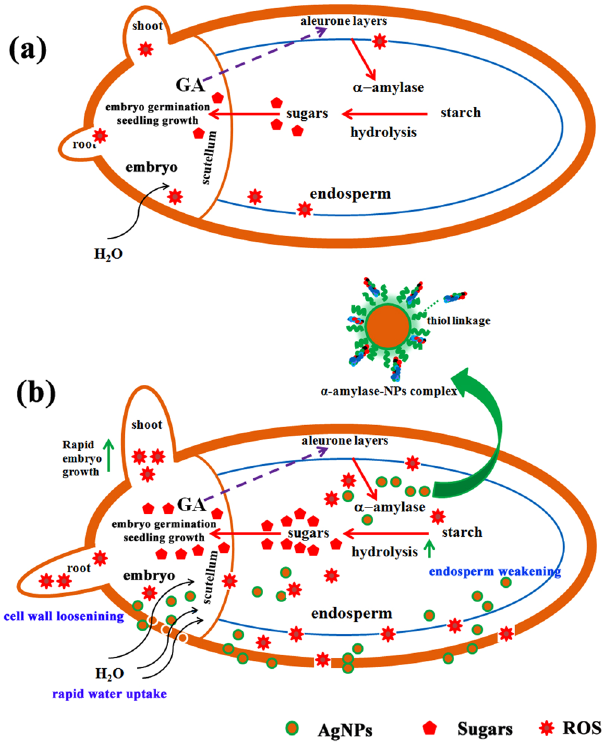
Figure 11. Proposed mechanism of AgNPs induced seed germination of rice. ( a ) Seed without AgNPs priming treatment has low metabolic activity due to slow water uptake; in this condition, the hydrolysis of starch occur gradually and thus available sugars is also low in the initial phase of imbibition, resulting in slow seed germination and seedling growth. ( b ) Seed priming with AgNPs can enhance seed germination with at least three possible scenarios. Firstly, AgNPs could penetrate seed coat by interacting with cell walls of seed coat to create small pores and thus enhance water uptake into seeds. Rapid water uptake can induce higher metabolic activity and starch hydrolysis of seed during initial phase of imbibition. Secondly, penetrated AgNPs could interact with α -amylase as NPs-amylase complex to fasten the starch hydrolysis and thus seed can generate higher available sugars to support embryo growth. Thirdly, AgNPs could mediate generation of ROS being in oxidative window range for acting as signalling molecules and participating in cell wall loosening and endosperm weakening. See texts for further